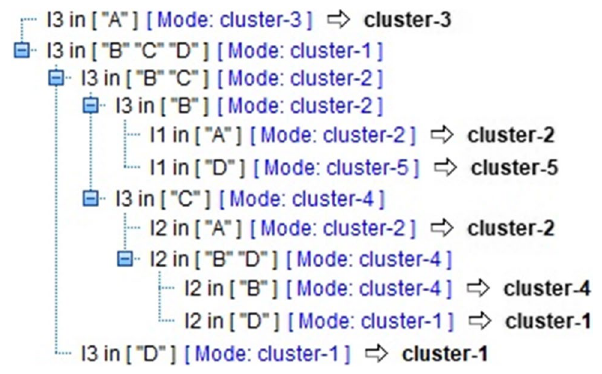
Fig. 7 The tree diagram of the CART algorithm in predicting five clusters Table 9 Frequencies and surrogates data of the branch A in I3 Frequencies